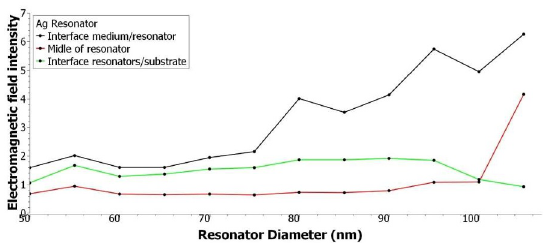
Fig. 4. Electromagnetic field intensity for silver nano-disks